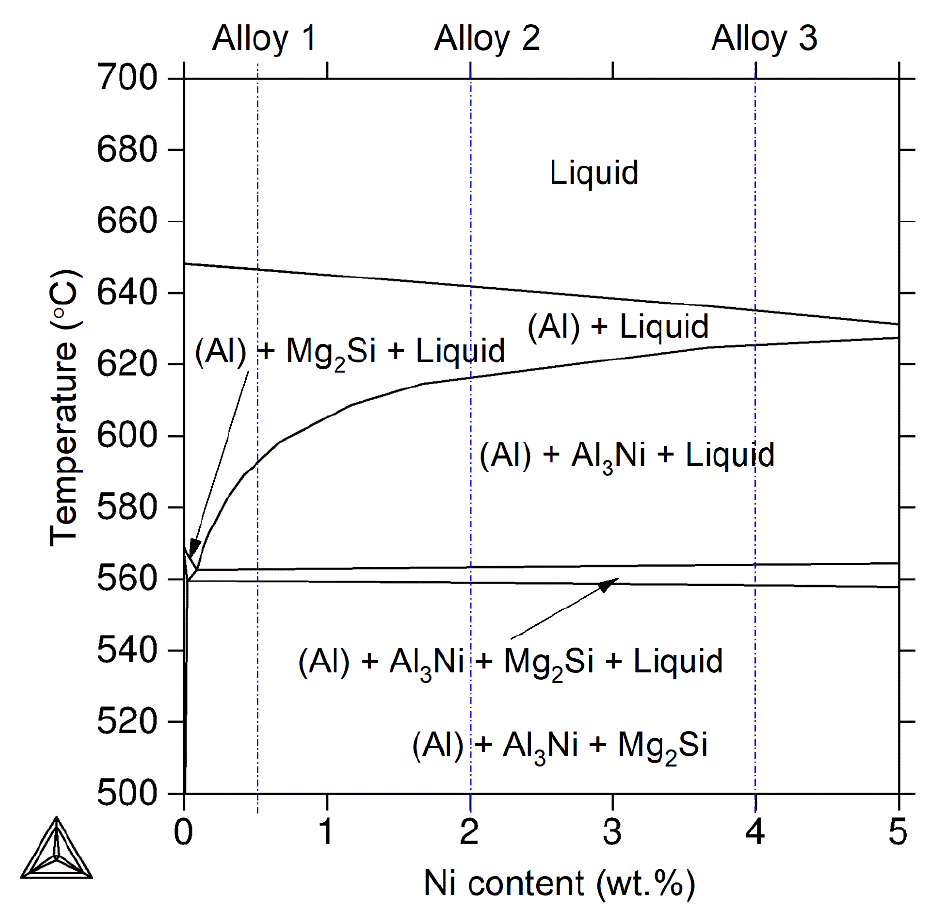
Figure 1. The polythermal section of the equilibrium Al-1.2%Mg-0.7%Si-1.0%Cu-var.%Ni phase diagram; blue vertical lines show the studied alloys compositions.